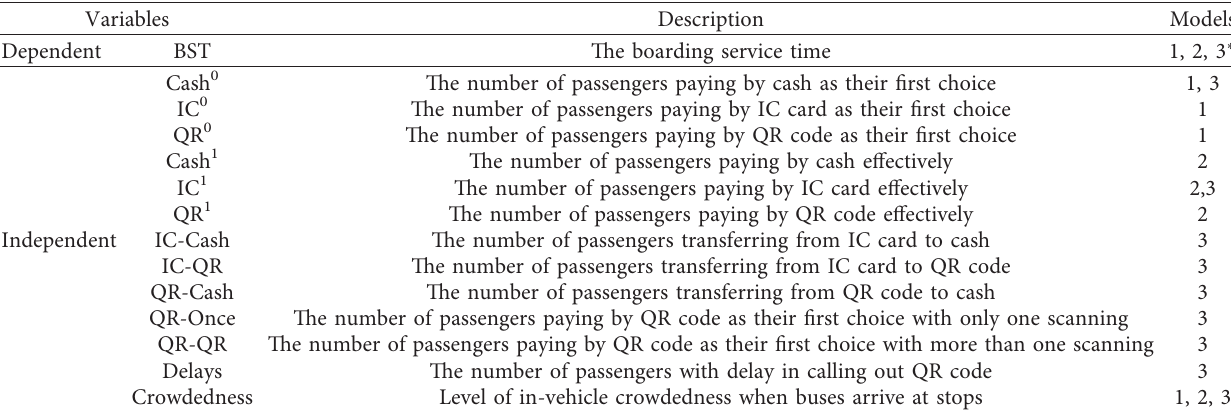
Table 1: Descriptions of the variables in regression models.